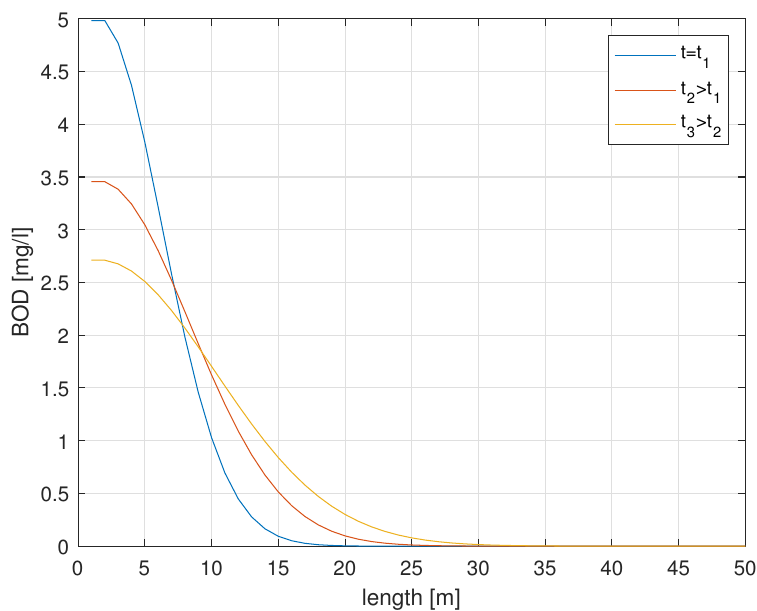
Figure 4. Distribution of BOD including diffusion at different times t .